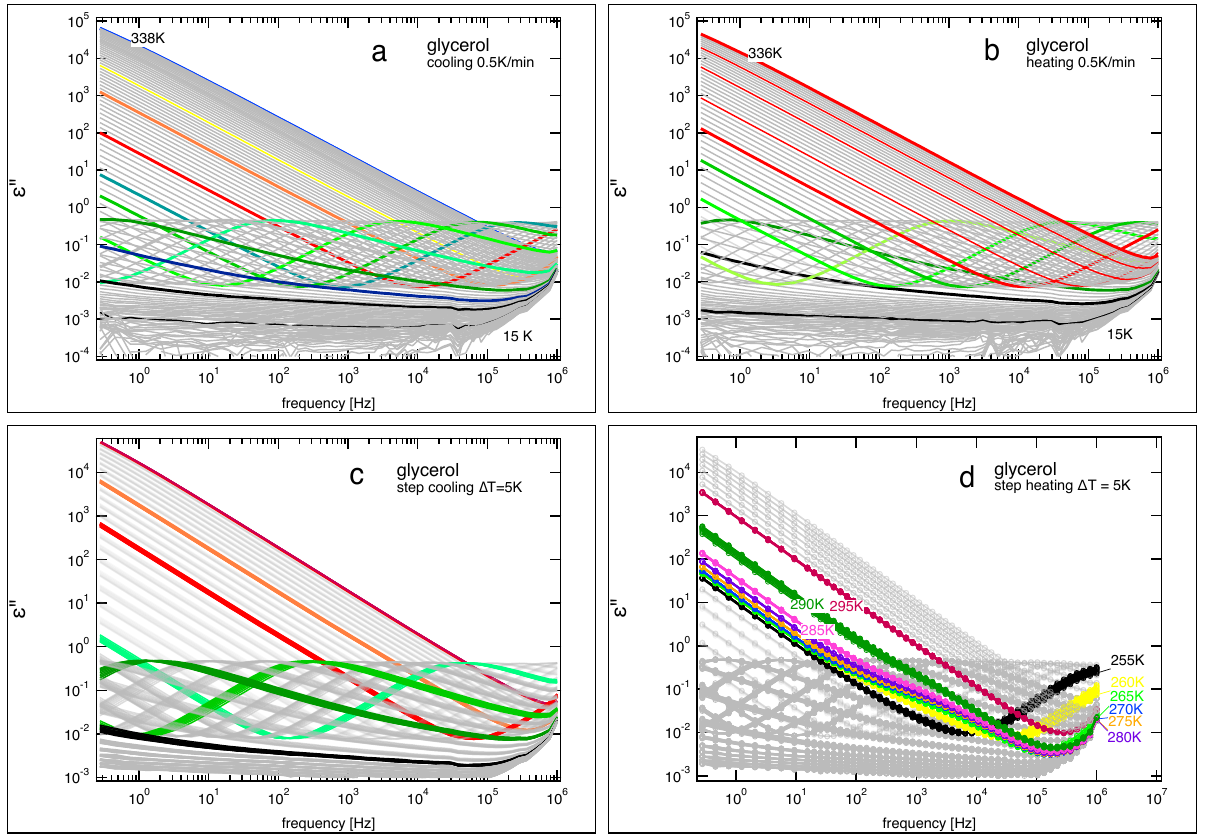
Figure 4. Frequency dependent dielectric permittivity at temperatures measured in: (a) continuous cooling scan with a ramp of 0.5 K / min, (b) continuous heating with the same rate, (c) in step cooling with ∆ T = 5K, followed by scans during temperature equilibration and (d) in step heating, followed by scans during temperature equilibration. With the slower rate in step heating crystallisation of glycerol is